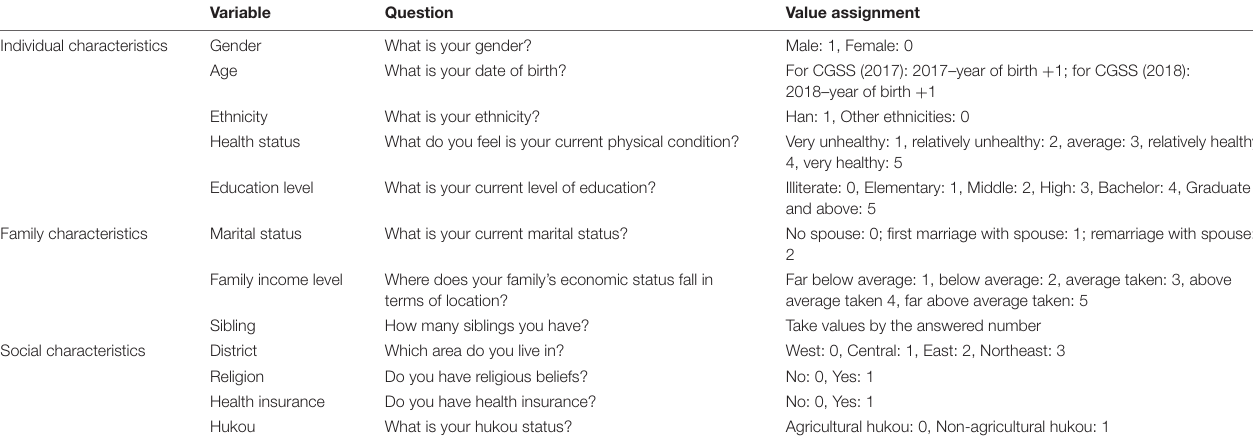
TABLE 2 | Independent variable statement.